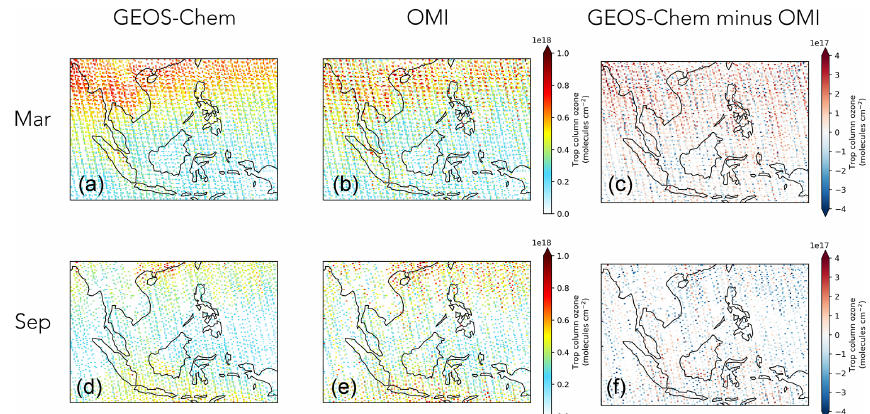
Figure 7. Spatial distribution of (a, d) the GEOS-Chem model and (b, e) OMI monthly mean tropospheric ozone column (molec.cm − 2 ) across Southeast Asia in March and September 2014. Panels (c) and (f) show the difference between GEOS-Chem and OMI for March and September, respectively. Ozone columns are shown on the 0.25 ◦ × 0.3125 ◦ nested grid and are represented by white space where OMI observations are not available.